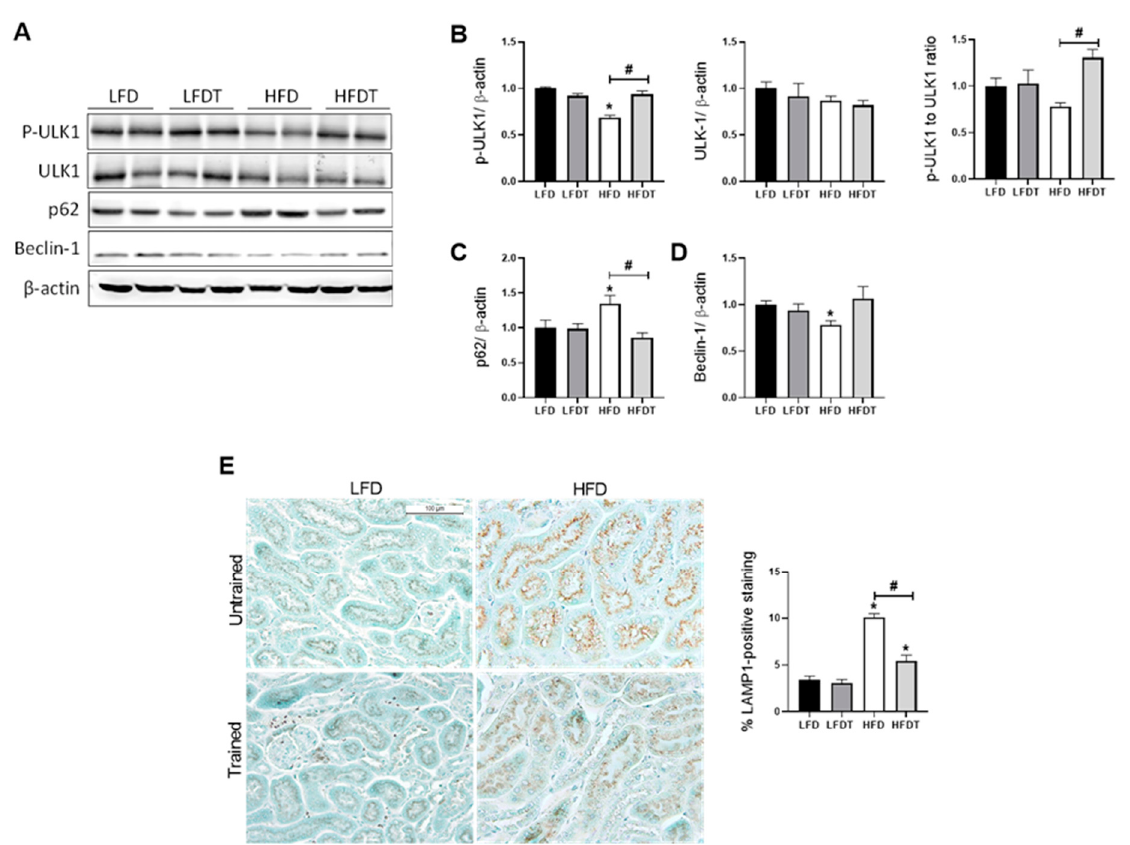
Figure 7. Effects of a delayed EET on autophagy and lysosomal markers in the kidney from mice on LFD or HFD. ( A ) Western Blot analysis of phospho-ULK-1 (Ser 555), ULK-1, p62 and Beclin-1 in kidney tissue from mice LFD, LFDT, HFD and HFDT. ( B ) Relative densitometry of the immunoblots representing, respectively, phosphor-ULK1 (Ser 555) protein level normalized with β -actin, ULK-1 protein level normalized with β -actin and Phospho-ULK1 (Ser 555) to ULK-1 ratio. ( C ) Relative densitometry of the immunoblots representing p62 protein level normalized with β -actin. ( D ) Relative densitometry of the immunoblots representing Beclin-1 protein level normalized with β -actin. ( E ) Representative photomicrograph (original magnification ×400; scale bar: 100 μ m) showing lysosomal-associated membrane protein 1 (LAMP1)–positive staining on intracellular vacuoles and related quantitative analysis of LAMP1-positive staining. Statistical analyses were performed by one-way ANOVA followed by Newman–Keuls post hoc test. Data are presented as means ± SEM. * p ≤ 0.05 versus LFD # p ≤ 0.05 versus HFD. n = 6–8 in each group.